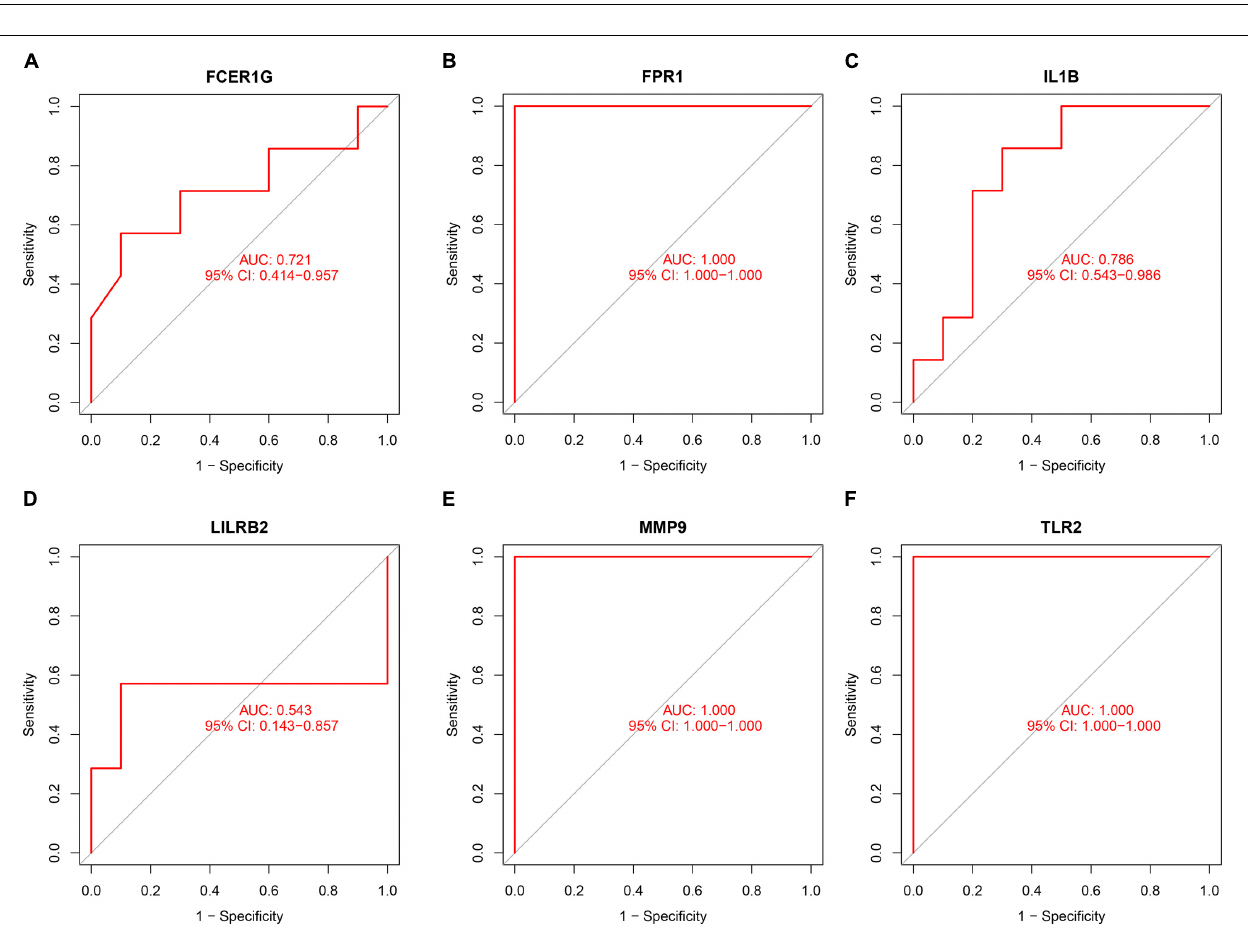
FIGURE 8 | Diagnostic value of top six hub genes with receiver operating characteristic (ROC) curves. (A) Analysis with ROC curves. (B) Specific value of diagnosis efficiency.